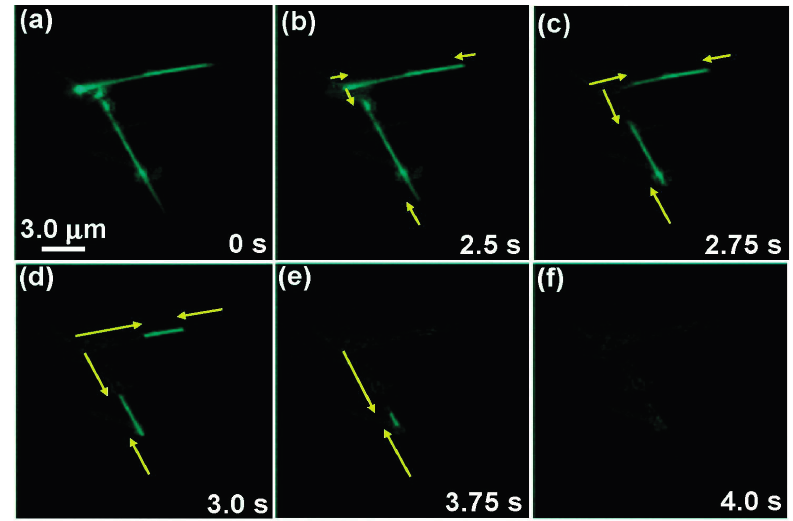
Figure 3. Microscopic images of the NBD nanotubes upon the addition of the fluorescence acceptor dye QSY7, which quenches NBD via FRET. Reprinted with permission from Kameta et al. [85]. Copyright 2007 American Chemical